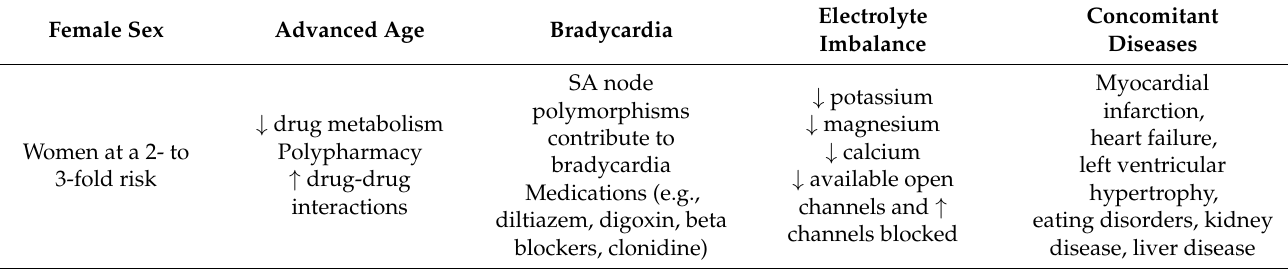
Table 3. Risk Factors for Long QT Syndrome